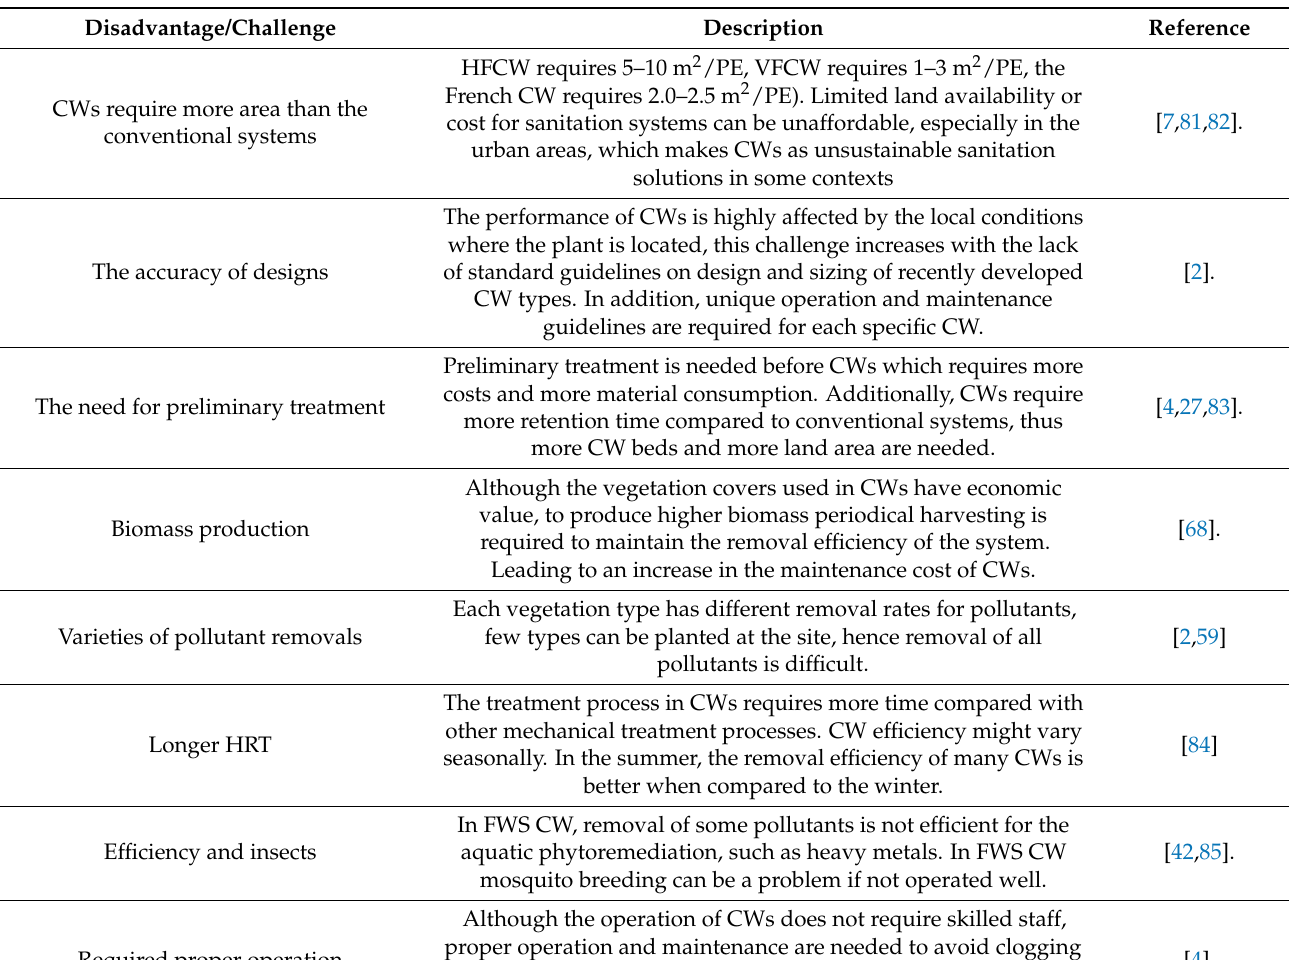
Table 2. Disadvantages/challenges of applying